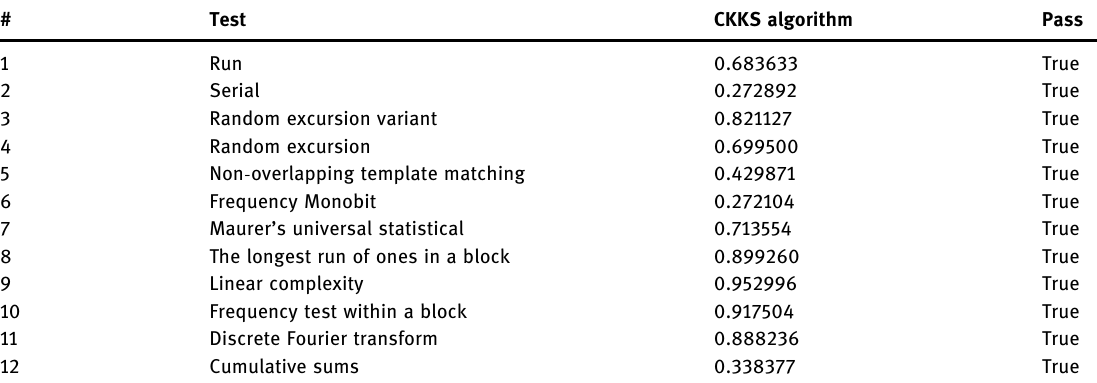
Table 9: NIST test in CKKS algorithm